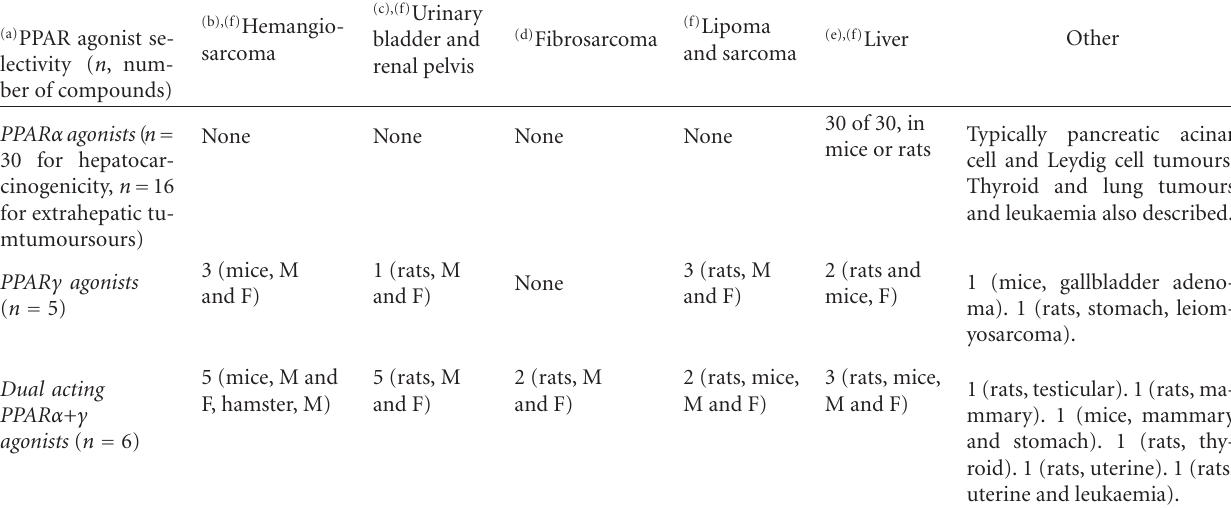
Table 1: Frequency of cancer findings for PPAR agonists in rats, mice, and hamsters. The table is adapted from [8–10] and comprises rodent carcinogenicity data for between 16 and 30 PPAR α agonists (pharmacological as well as industrial compounds) [9, 10], 5 PPAR γ agonists (pharmacological compounds only) [8], and 6 dual-acting PPAR α + γ agonists (pharmacological compounds only) [8]. Numbers in the cells: number of compounds causing the indicated pathology in the indicated rodent species; M: male; F: female. The di ff erence in rodent bladder and liver tumour frequency between PPAR α , PPAR γ , and PPAR α + γ agonists is significant ( P < . 0001, Chi-square test). The di ff erence in rodent bladder cancer frequency betwen PPAR γ and dual-acting PPAR α + γ agonists is borderline significant ( P = . 0357 and .081 by Chi-square and Fischer’s exact tests,